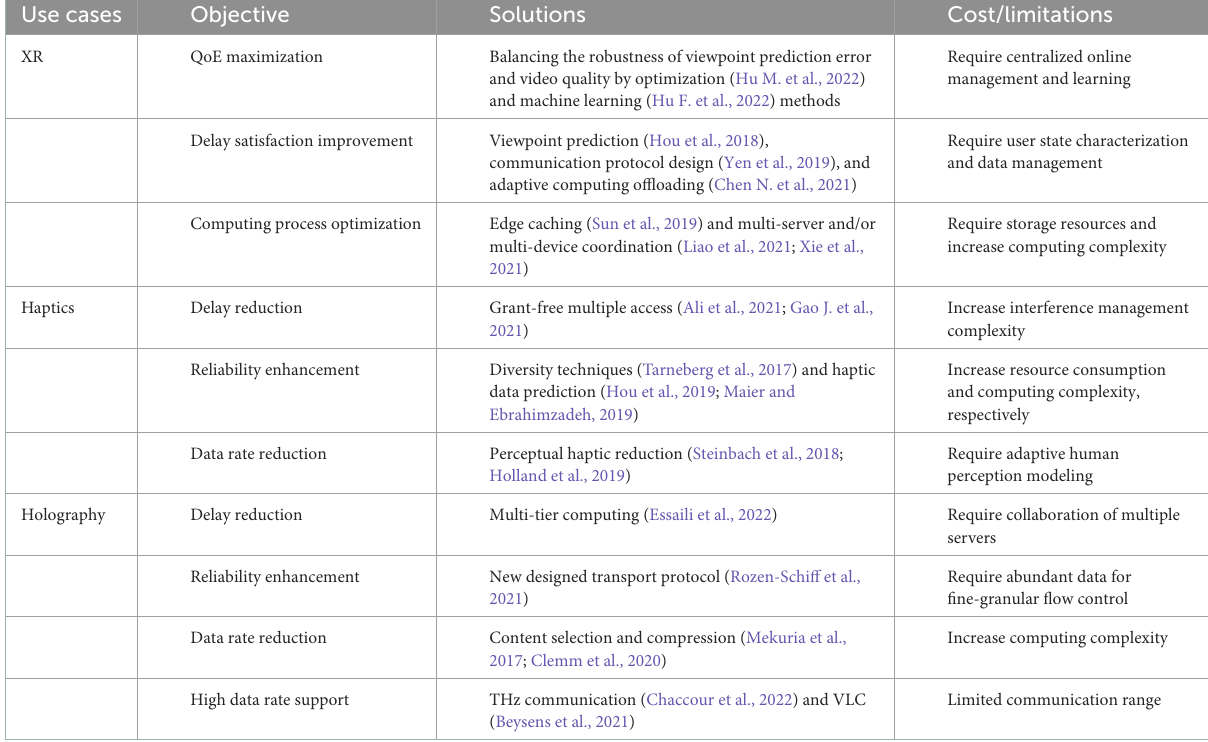
TABLE 4 Potential solutions to immersive communications and the